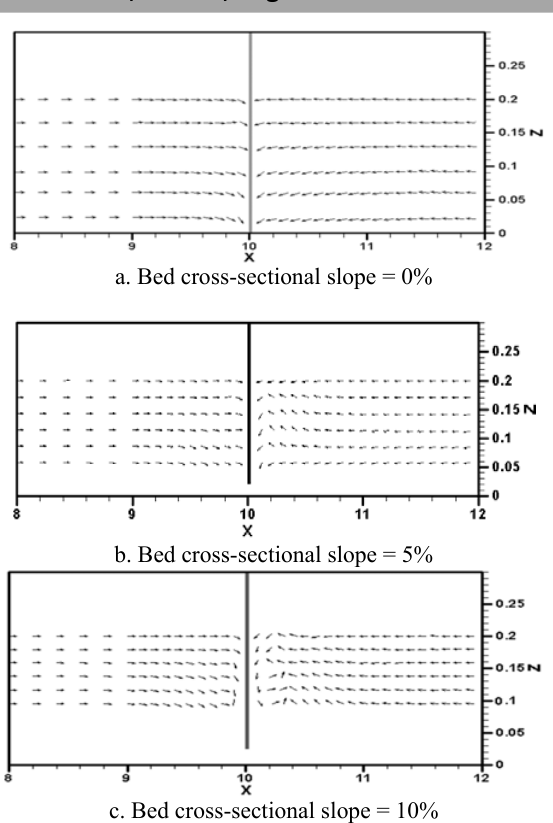
Fig.15 Velocity fields in the vertical plane at y= 0.25m for the groyne with structural slope= 1:0 at various cross- sectional bed slopes